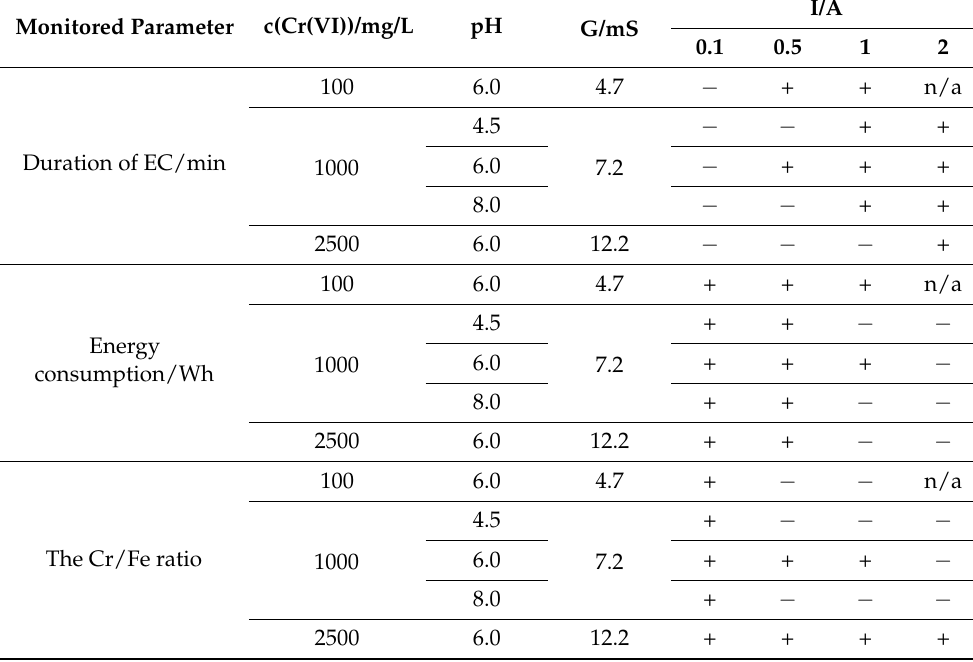
Table 4. Scheme of suitable (+) and unsuitable ( − ) experimental conditions for the EC process of low, medium, and high concentrations of chromium solutions.